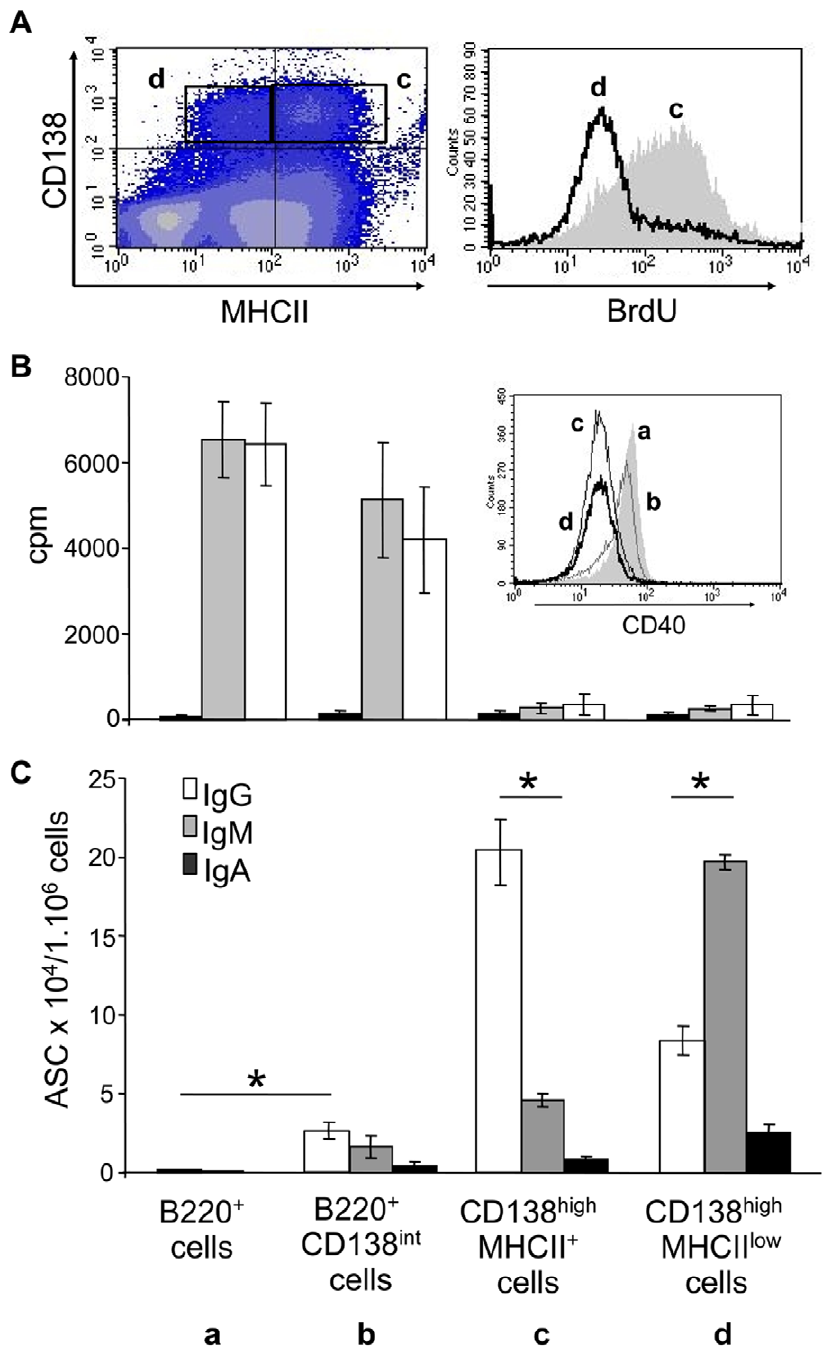
Figure 3. Each cell subset displays distinct proliferative and secretory abilities. A) In vivo proliferation upon BrdU administration to diseased NZB/W mice. Upon intra-peritoneal injection and five days feeding with BrdU, mice were killed and spleen cell subsets were analyzed for proliferation by flow cytometry. Among CD138 high cells, mostly MHCII low cells (‘‘d’’ subset) did not incorporate BrdU as shown on the histogram. B) and C) The four spleen cell subsets (a to d, as described in Figure 1) were sorted by flow cytometry from the spleen of diseased NZB/W mice. (B) Sorted cells were incubated for 3 days without stimulation (black bars), with LPS (gray bars) or with agonistic anti-CD40 Ab (white bars). Proliferation was measured upon tritiated thymidine uptake for 18 h and results are expressed as mean cpm + / 2 SEM. In the insert is shown the expression of CD40 by the four spleen cell subsets. (C) Cells were tested for spontaneous Ig secretion by ELISpot upon a 6 h-culture period. The three main Ig isotypes were tested: IgG (white bars), IgM (grey bars) and IgA (black bars). Results are expressed as the number of Ab-secreting cells (ASC) per 1 6 10 6 cells (mean + / 2 SEM). *statistically significant differences of interest ( p , 0.05, Mann-Whitney U test). doi:10.1371/journal.pone.0058140.g003 plasma cells. We thus administered BrdU to diseased NZB/W short-lived plasma cells from the non-proliferating BrdU 2 long- mice for 2 weeks, in order to differentiate proliferating BrdU + lived ones (Figure 4F). Interestingly, some long-lived cells were